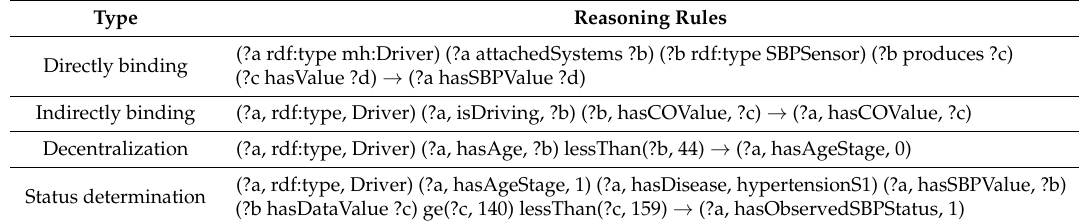
Table 3. Typical rule